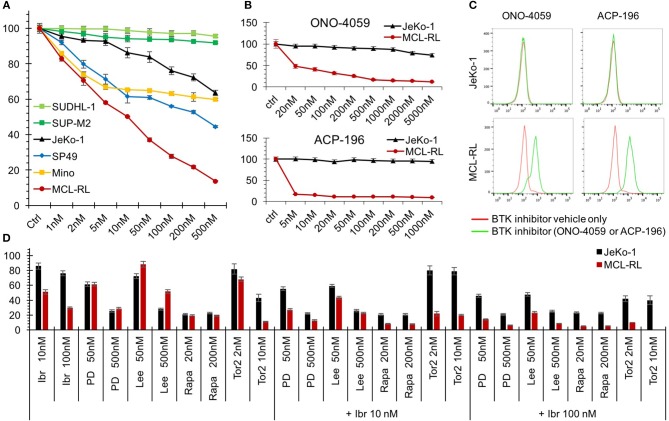
Sensitivity of MCL-RL cells to clinically relevant kinase inhibitors. (A) Evaluation of cell growth inhibition of MCL cells by BTK inhibitor Ibrutinib. MCL cell lines MCL-RL, Mino, SP49, and JeKo-1 were cultured for 72 h in the presence of the depicted doses of Ibrutinib and evaluated for growth inhibition using MTT conversion assay. T-cell lymphoma cell lines expressing NPM-ALK chimeric kinase SUP-M2 and SUDHL-1 served as negative controls. The results are depicted as the percentage of response with the cells cultured in medium containing drug vehicle alone (Ctrl) serving as the reference value (100% response). (B) Evaluation of MCL cell growth inhibition by second-generation BTK inhibitors ONO-4059 and ACP-196. MCL-RL and JeKo-1 cells were cultured for 48 h in the presence of the depicted doses of the inhibitors and analyzed for growth inhibition in the MTT conversion assay. The results are depicted as the percentage of response with the cells cultured in medium containing drug vehicle alone (Ctrl) serving as reference (100% response). (C) Analysis of BTK inhibition effect on apoptotic cell death. JeKo-1 and MCL-RL cells were cultured for 72 h with either ONO-4059 or ACP-196 BTK inhibitor (green lines) or drug vehicle alone (red lines) and examined for DNA fragmentation in the TUNEL assay. (D) Evaluation of MCL cell growth inhibition by clinically relevant kinase inhibitors. JeKo-1 (black columns) and MCL-RL (red columns) cells were cultured for 48 h at the depicted drug doses with BTK inhibitor ibrutinib (Ibr), CDK4/6 inhibitors PD0332991 (PD), or Lee011(Lee), or indirect mTORC1 inhibitor rapamycin (Rapa) or direct mTOR inhibitor Torin2 (Tor2), either alone or in combination with ibrutinib. The results are depicted as the percentage of response with the cells cultured in medium containing drug vehicle alone serving as reference (100% response).